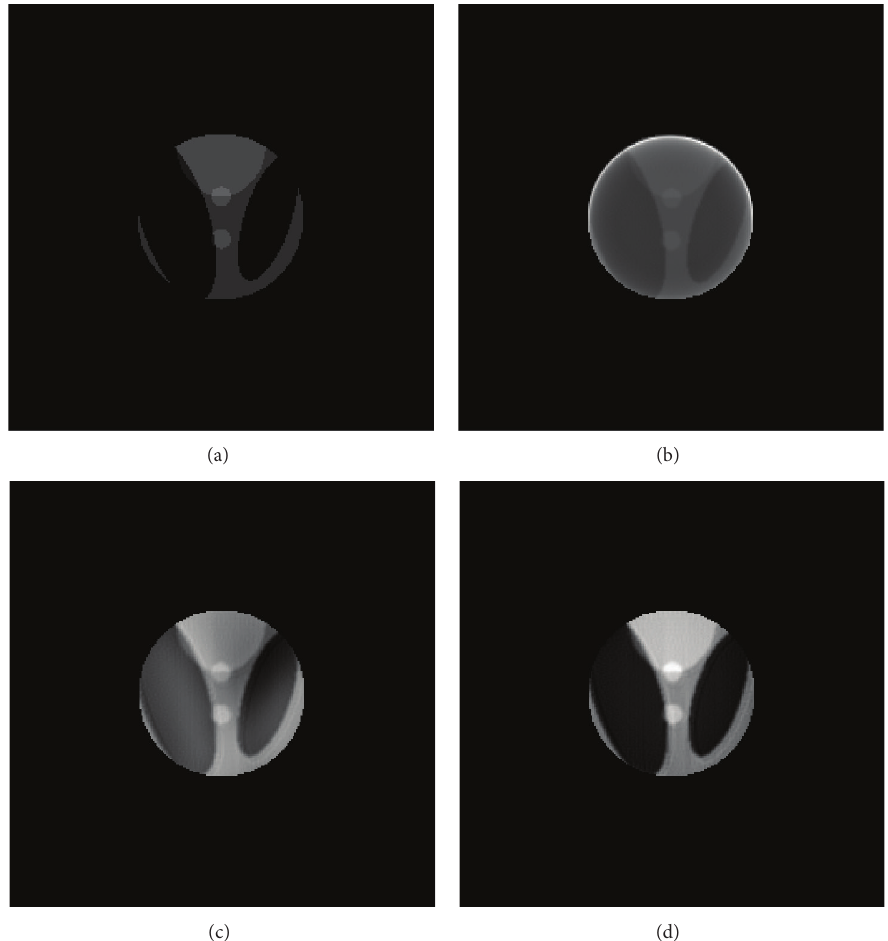
Figure 7: Reconstructed images of the local area in Shepp-Logan head phantom. (a) Local area in the phantom. (b) Local reconstruction using FBP. (c) Using wavelet method in [13]. (d) Using new wavelet method in this